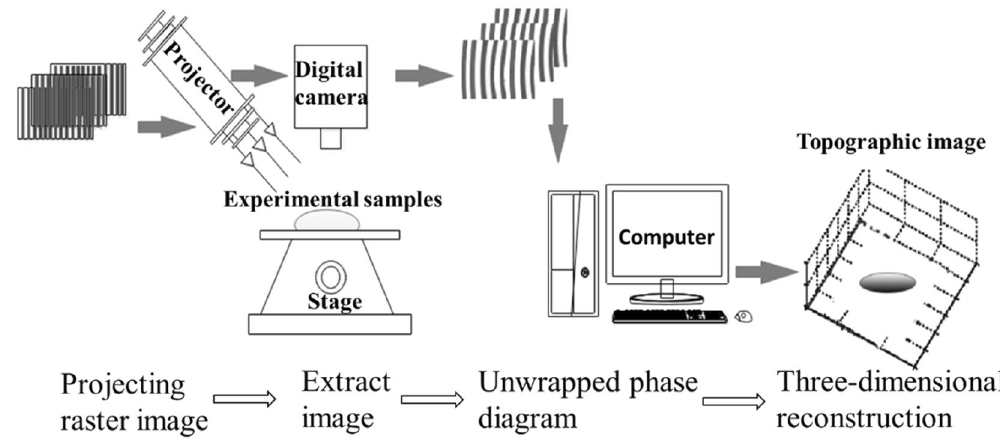
Figure 1. Principle of fringe projection and phase-shifting